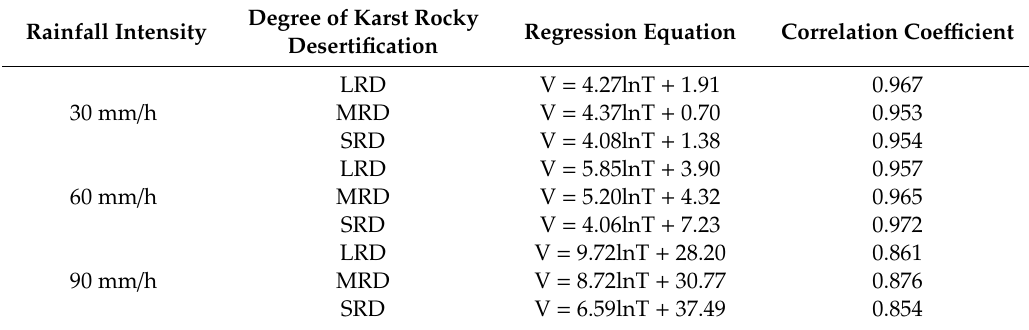
Table 2. Regression analysis of cumulative underground runo ff and runo ff duration. Rainfall Intensity